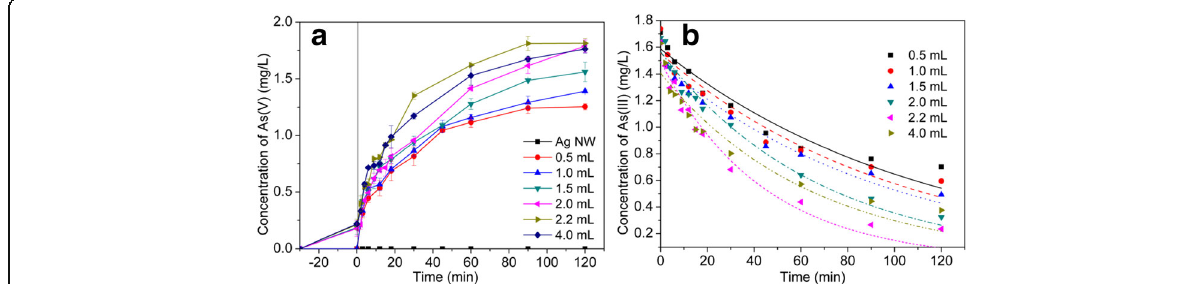
Fig. 5 a Photocatalytic activities of Ag@AgCl core – shell nanowires for As(III) oxidation under visible-light irradiation. b Pseudo first order plot of